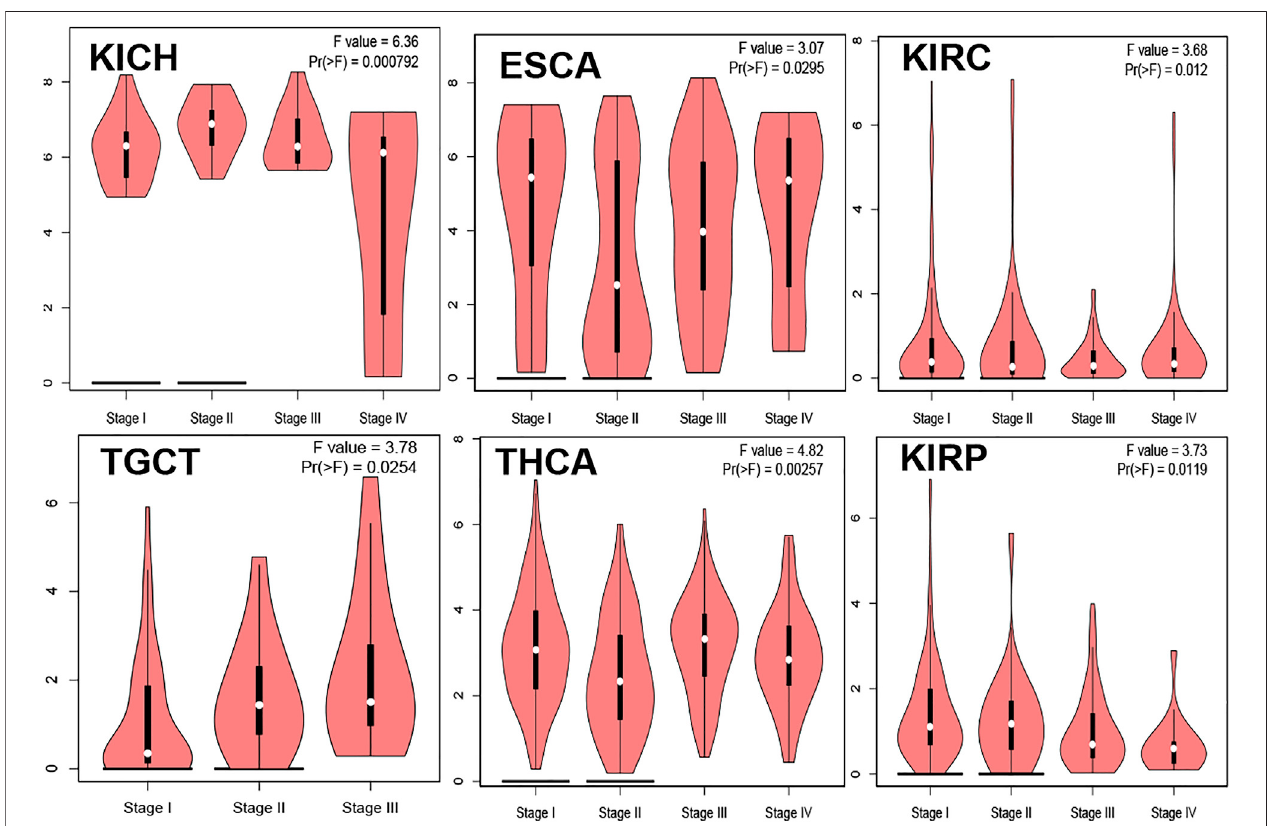
FIGURE 11 | DFS data in malignant tumors with low TMPRSS2 expression. (A) Survival picture of tumors with low TMPRSS2 expression; (B) DFS in tumors with low TMPRSS2 expression.